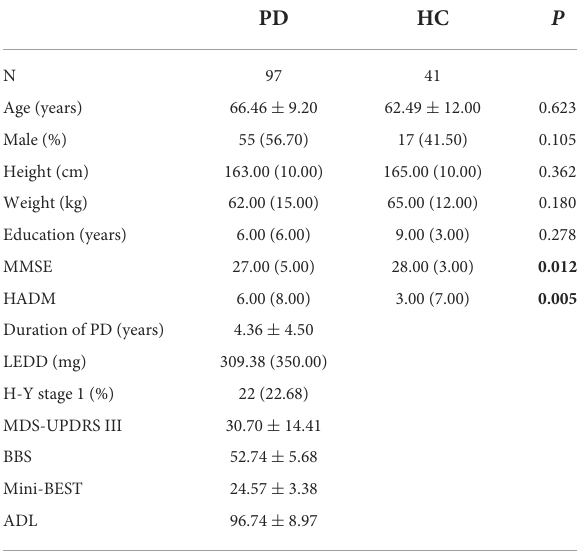
TABLE 1 Clinical characteristics of